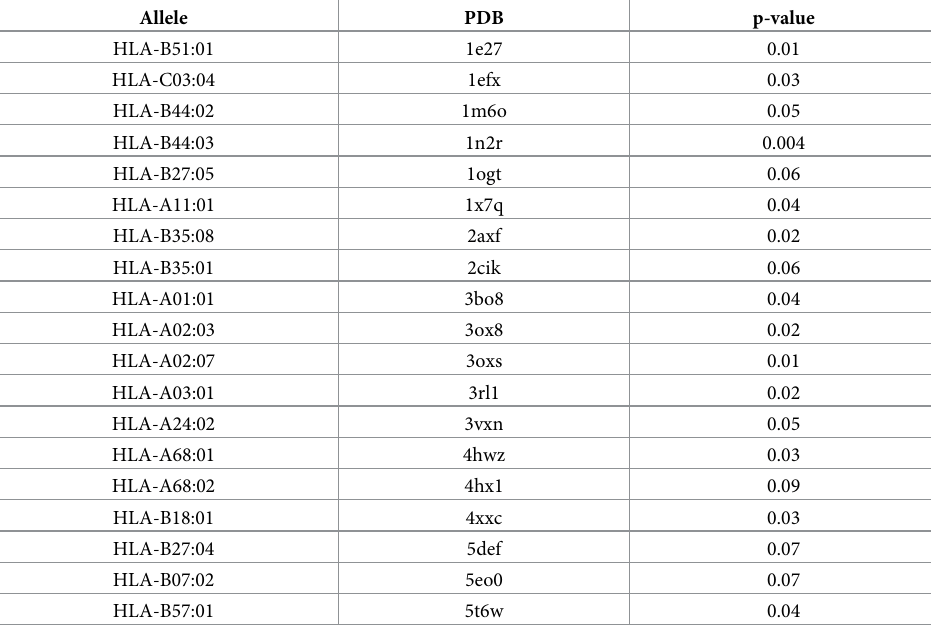
Table 1. Enrichment of non-polymorphic sites with respect to stability evaluated in different structures. The p- values of enrichment analysis (column 3, also see Fig 3B) of non-polymorphic residues among sites contributing most to protein stability using different pdb structures (column 2) of MHC-I alleles (column 1) is shown below. For each pdb structure, we merged the peptide and the MHC-I allele on the same chain and ran AlaScan to measure the stability scores. Allele PDB p-value